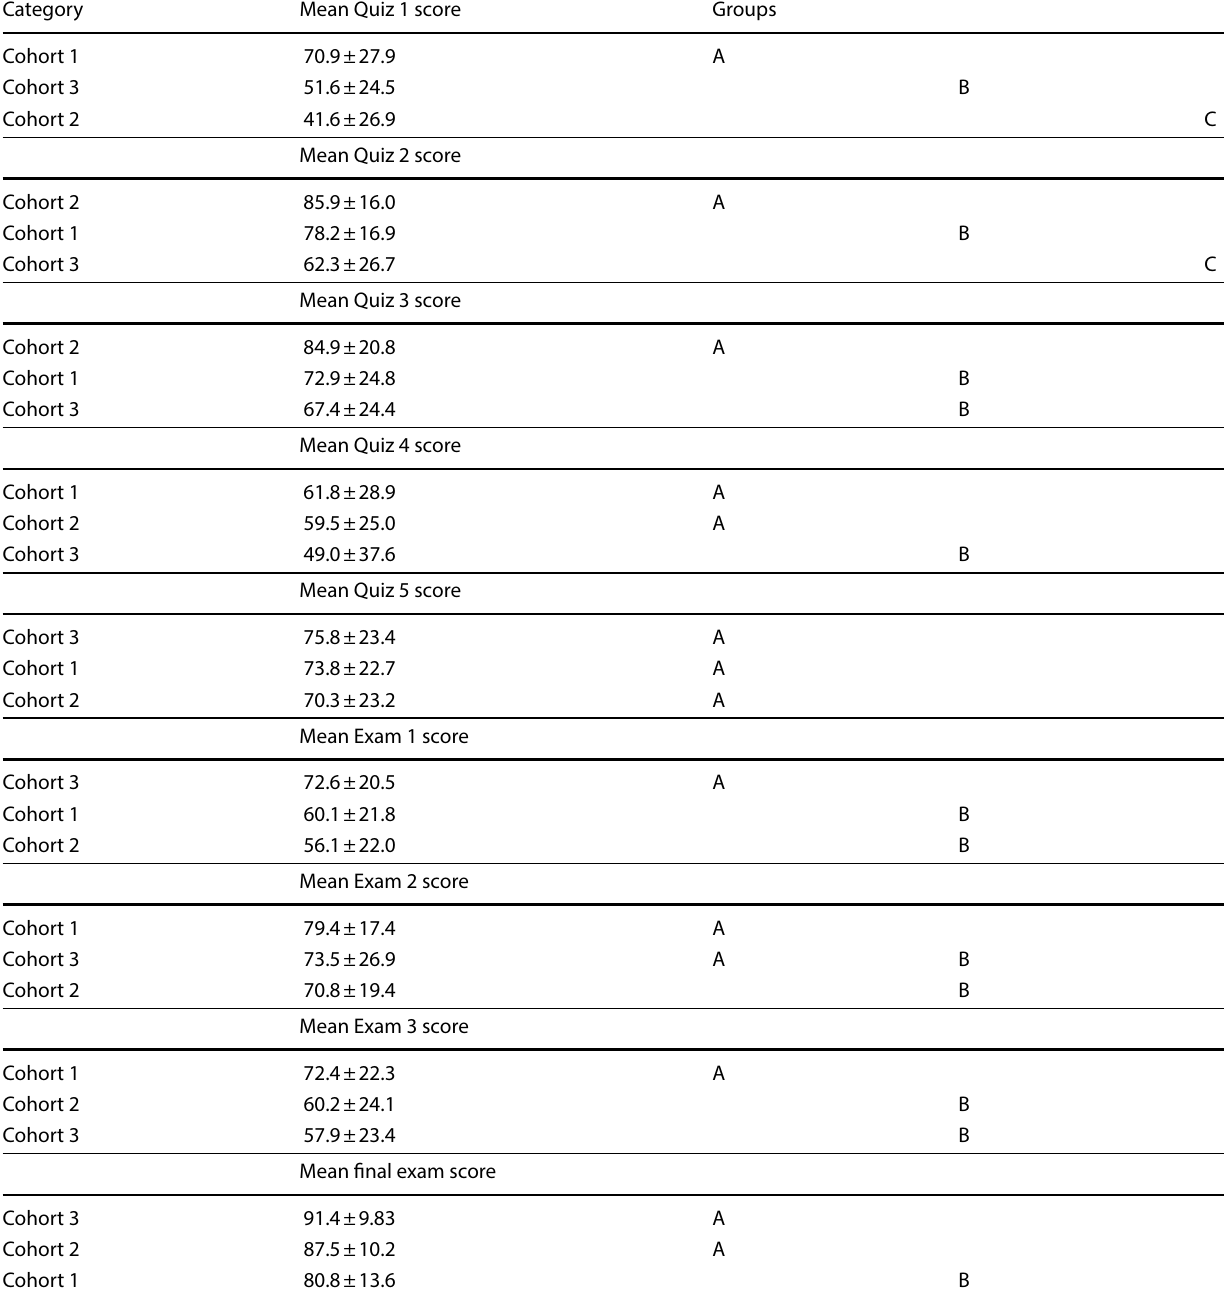
Table 3 Comparison of cohort exam performances